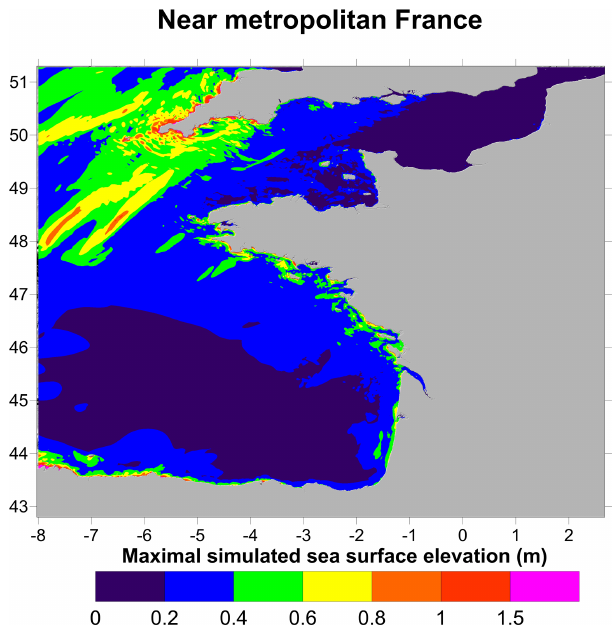
Figure 21. Maximum surface elevations (m) computed by FUNWAVE-TVD for the 80km 3 scenario on the western French coasts at a 450m resolution.